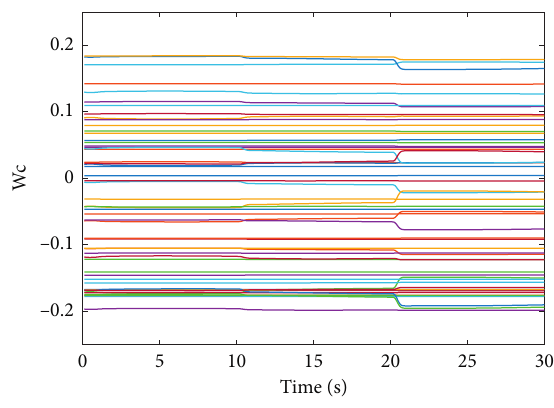
Figure 19: Wc1 of critic network.